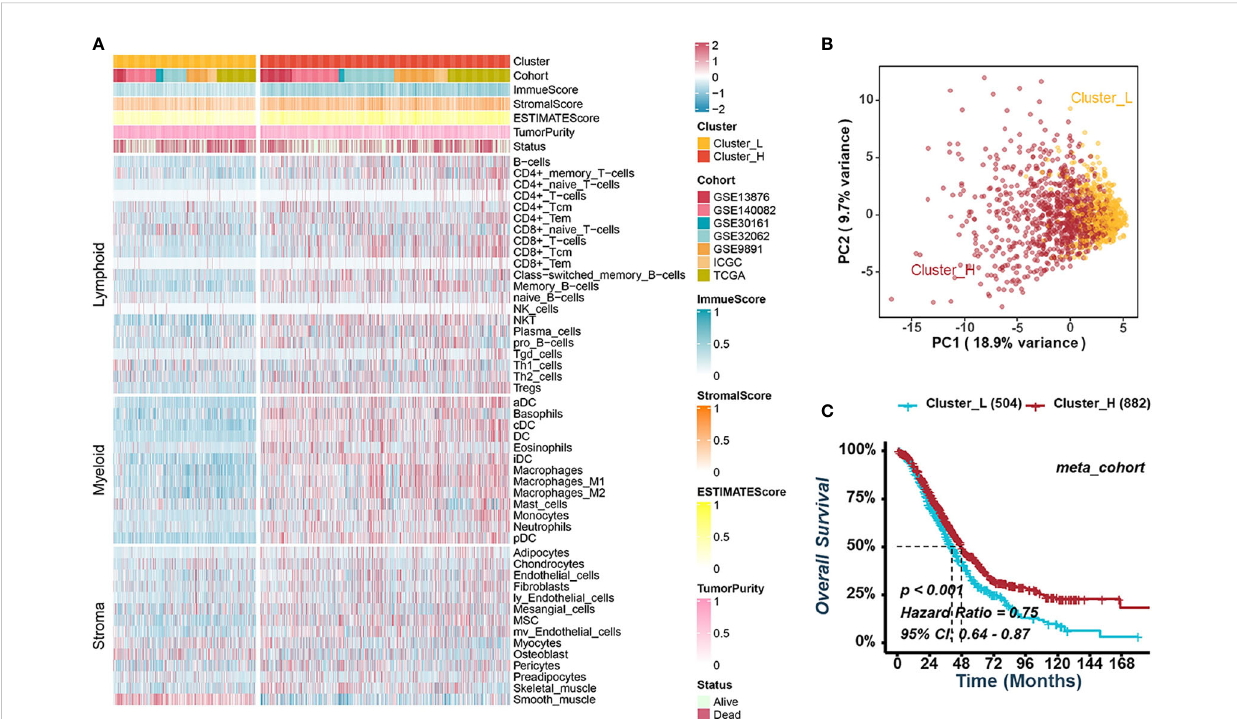
FIGURE 1 Consensus clustering for TME-in fi ltrating cells in HGSOC. (A) Heatmap illustrating the in fi ltration of immune and stromal cells between clusters-L and cluster-H in the meta-cohort. (B) Principal component analysis suggesting two distinct clusters in the meta-cohort. (C) Kaplan-Meier analysis estimating the overall survival between cluster-L and